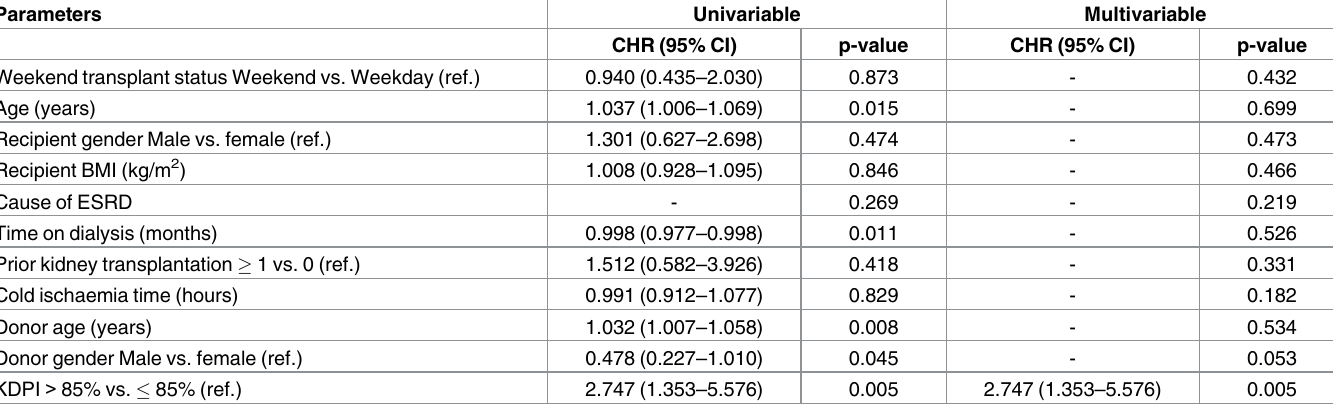
Table 4. Transition-specific Cox regression model for the transition to graft